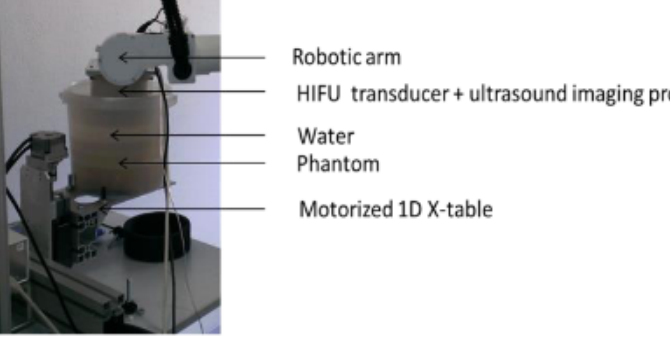
Figure 9. Six-DoF motion-compensated HIFU system developed by Chanel et al. [23]. Motion compensation is enabled through ultrasound motion estimation using speckle